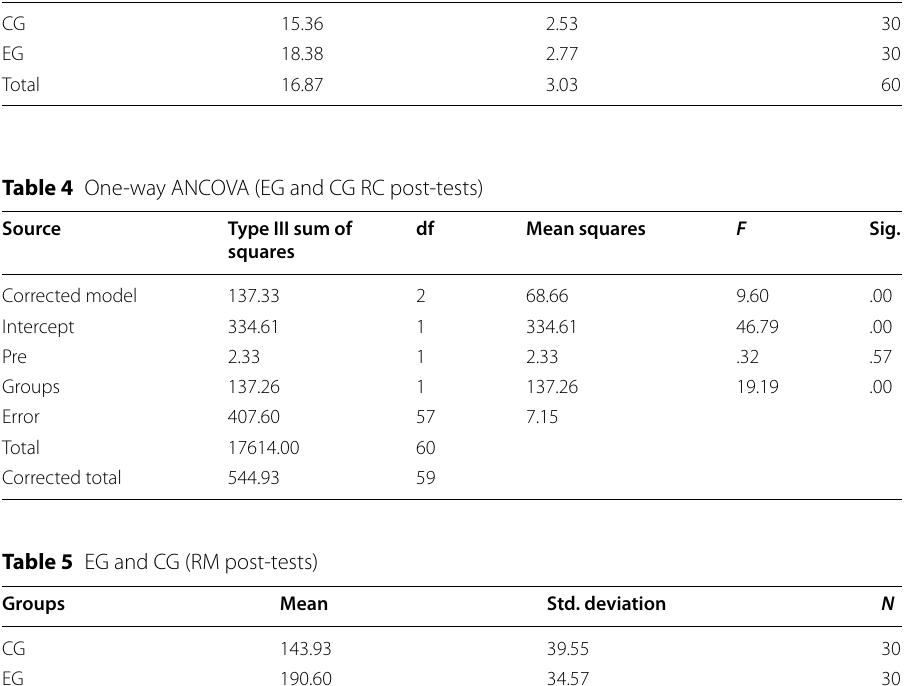
Table 3 EG and CG (RC post-tests) Groups